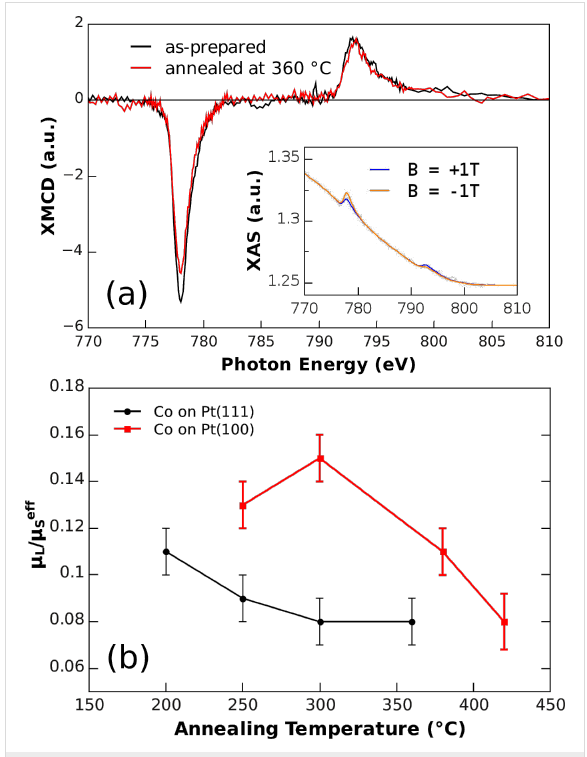
Figure 4: Panel (a) shows XMCD difference spectra for Co NPs on Pt(111) in the as-prepared state and after annealing at 360 °C for 30 min (final state). The inset displays the absorption spectra for external fields of µ 0 H = ± 1T in the as-prepared state. Panel (b) presents the resulting ratios of orbital-to-spin moments for Co NPs on Pt(111) and Pt(100) films as a function of annealing temperature T A (holding time 30 min). The lines are given as guides to the